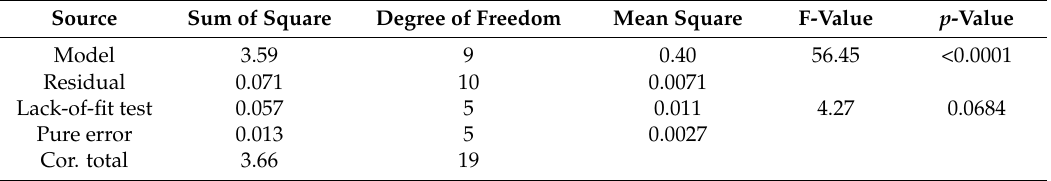
Table 4. Analysis of variance for a fitted quadratic model of extraction of the flavonoid compound. Source Sum of Square Degree of Freedom Mean Square Residual